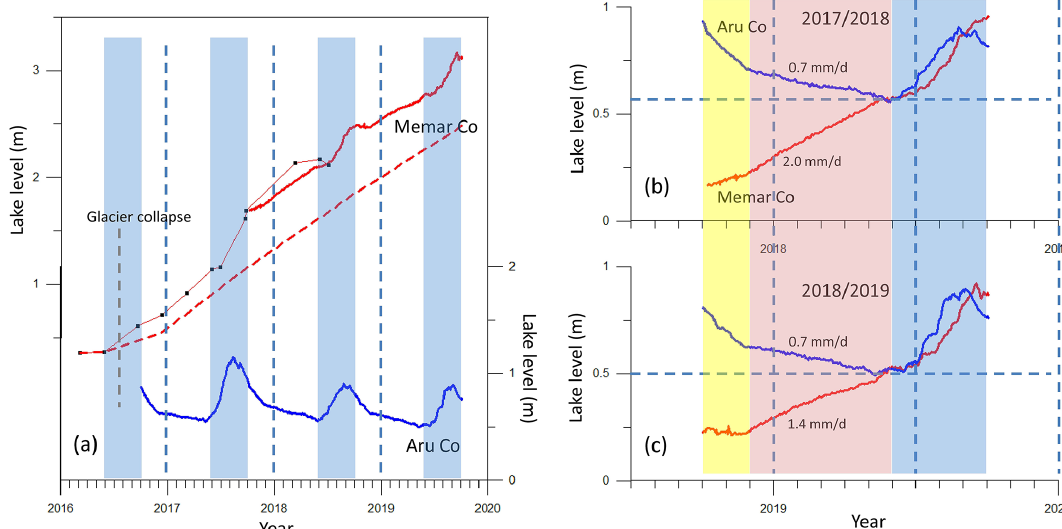
Figure 5. In situ lake level observations at Aru Co (blue line) and Memar Co (red line) between 2016 and 2019. (a) Lake level changes at Aru Co (blue line) and Memar Co (red line) between 2016 and 2019. The dashed red line indicates lake level changes at Memar Co without the fragmented ice melting. The black dots represents the lake level derived from CryoSat-2 altimetry data. (b–c) Comparisons of lake level changes at the two lakes in 2017/18 and 2018/19. The colored strips in (b) and (c) indicate different periods of lake level changes in a year, namely post-monsoon season, ice-covered season and monsoon season.